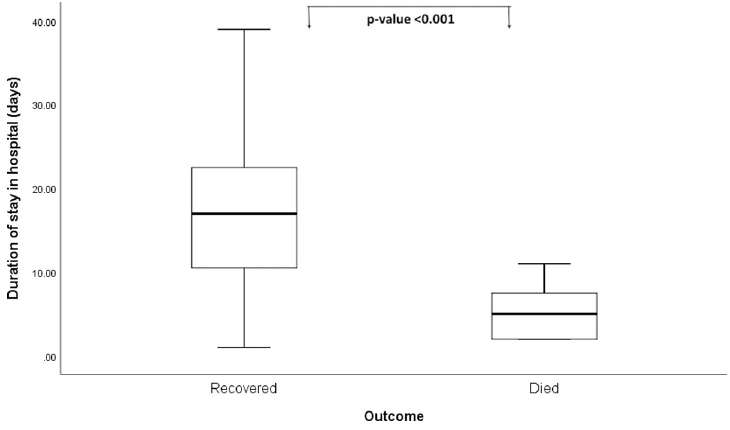
Fig 2. Boxplots showing the duration of hospital stay among tetanus patients categorized by outcome